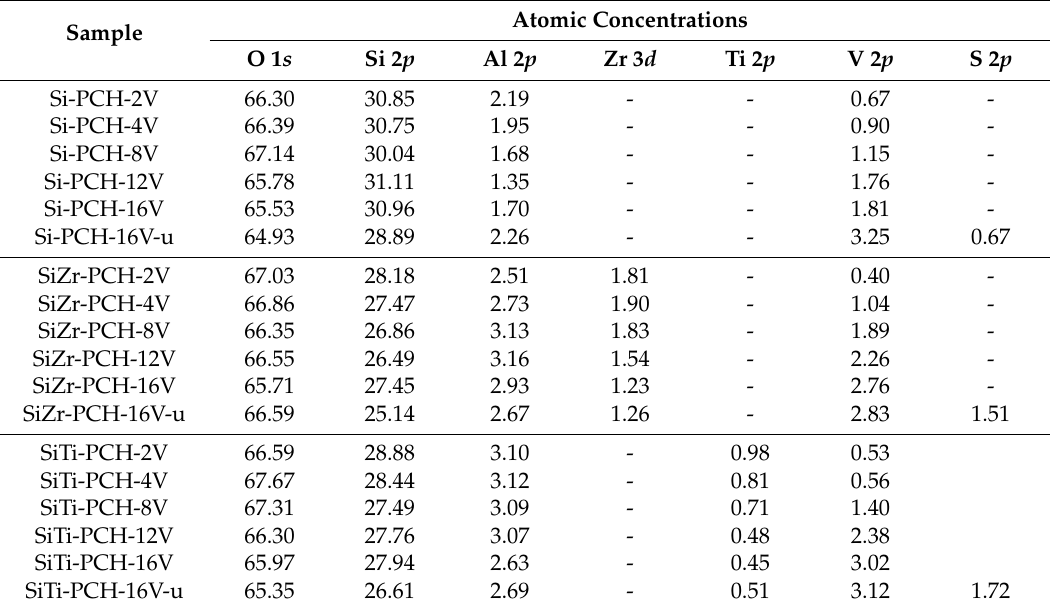
Table 2. Atomic concentrations (estimated by XPS) of the V-based catalysts.